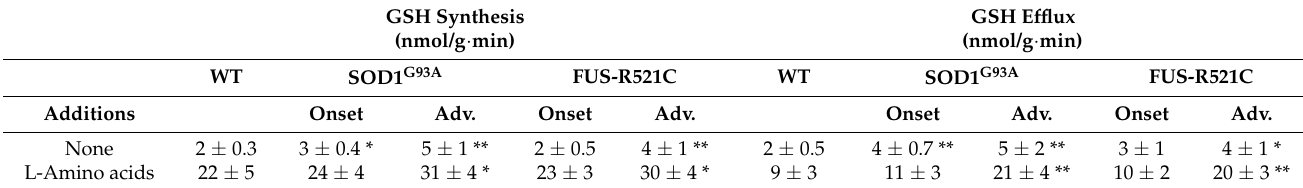
Table 1. Glutathione (GSH) synthesis and efflux in isolated hepatocytes from wild-type and ALS mice. The initial GSH concentration was 5.2 ± 0.3 µ mol/g in isolated hepatocytes from wild-type mice, 5.0 ± 0.4 and 4.0 ± 0.3 µ mol/g in isolated hepatocytes from SOD1 G93A mice (at onset and advanced state of progression, respectively) and 4.8 ± 0.4 and 3.7 ± 0.3 µ mol/g in isolated hepatocytes from FUS-R521C mice (at onset and advanced state of progression, respectively).